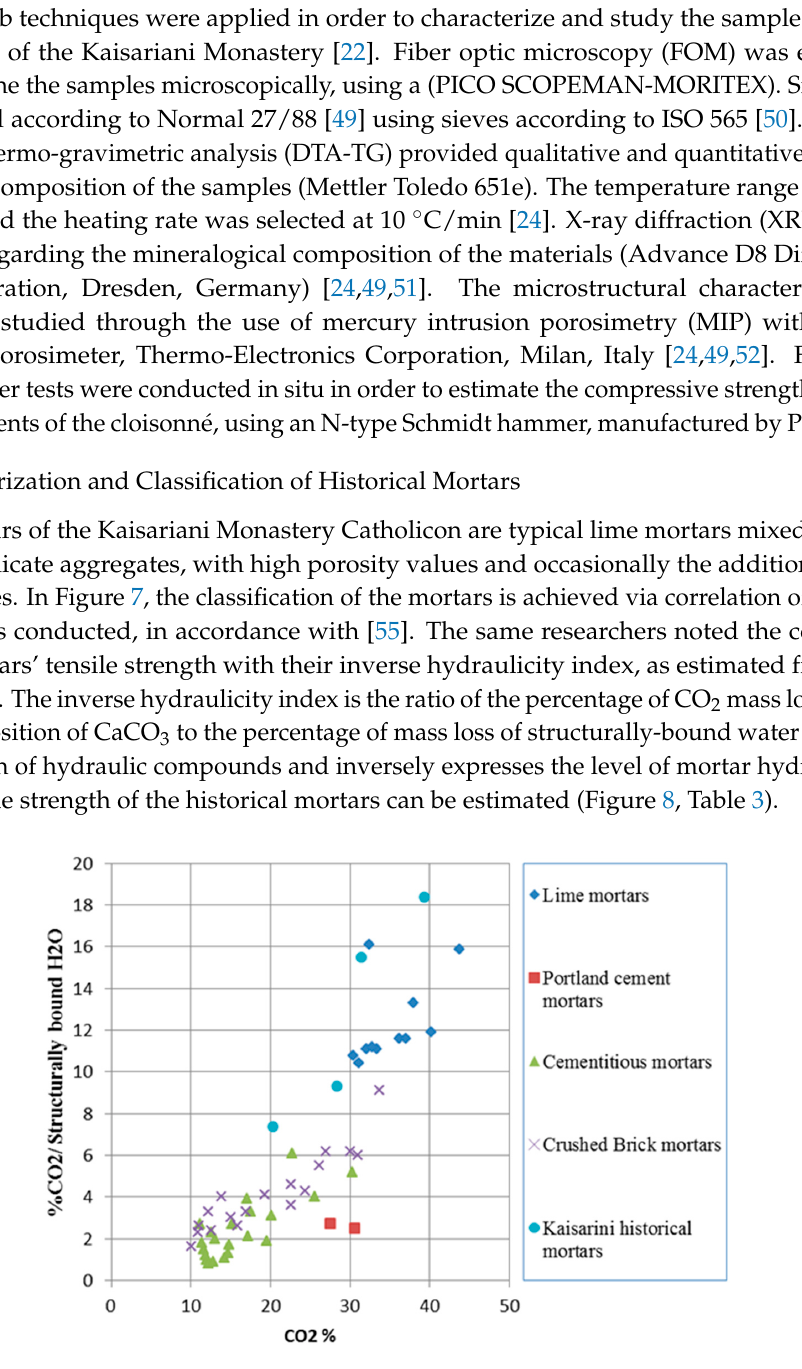
Figure 8. Correlation of tensile strength and inverse hydraulicity index.